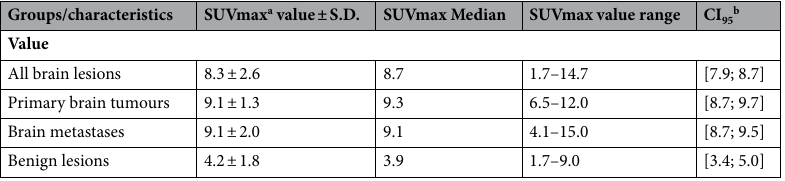
Table 1. The SUVmax calculations: benign, primary and metastatic brain tumours ( source: original data). S.D. standard deviation. a SUVmax—maximal standardized uptake value. b CI 95 —95% confidence interval (valid for at least 95% of studied population considering the SUVmax value